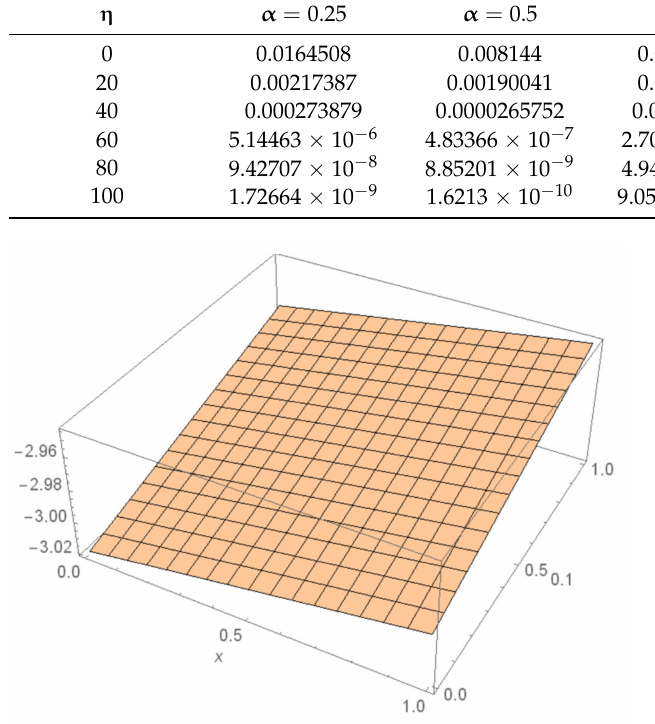
Figure 1. 3D plot of (cid:101) f ( η , t )